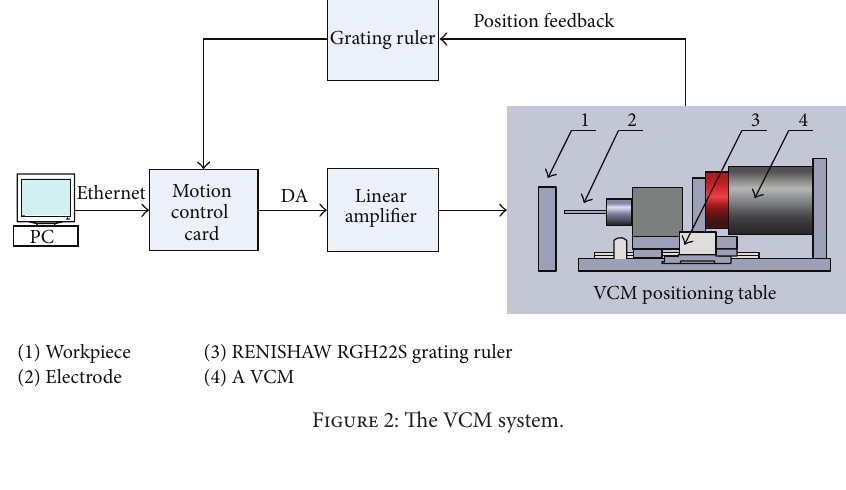
Figure 2: The VCM system.